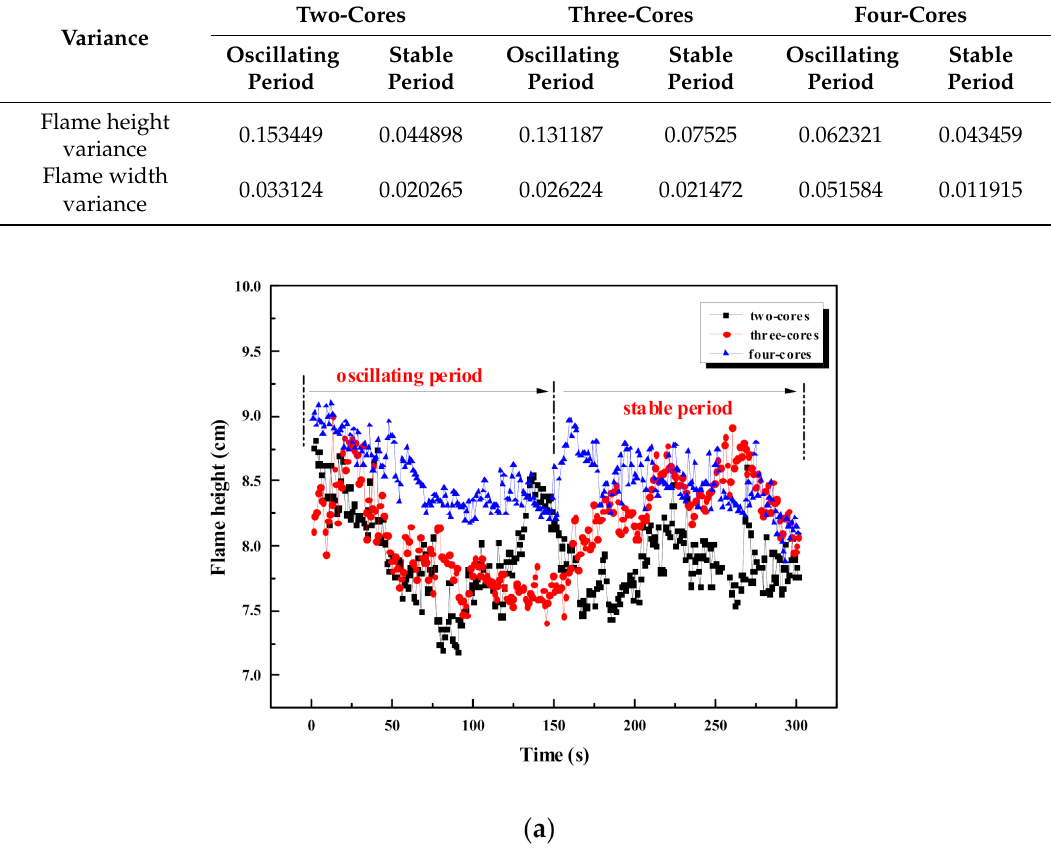
Table 3. Variance of flame height and width for cables with di ff erent cores in di ff erent periods. Variance